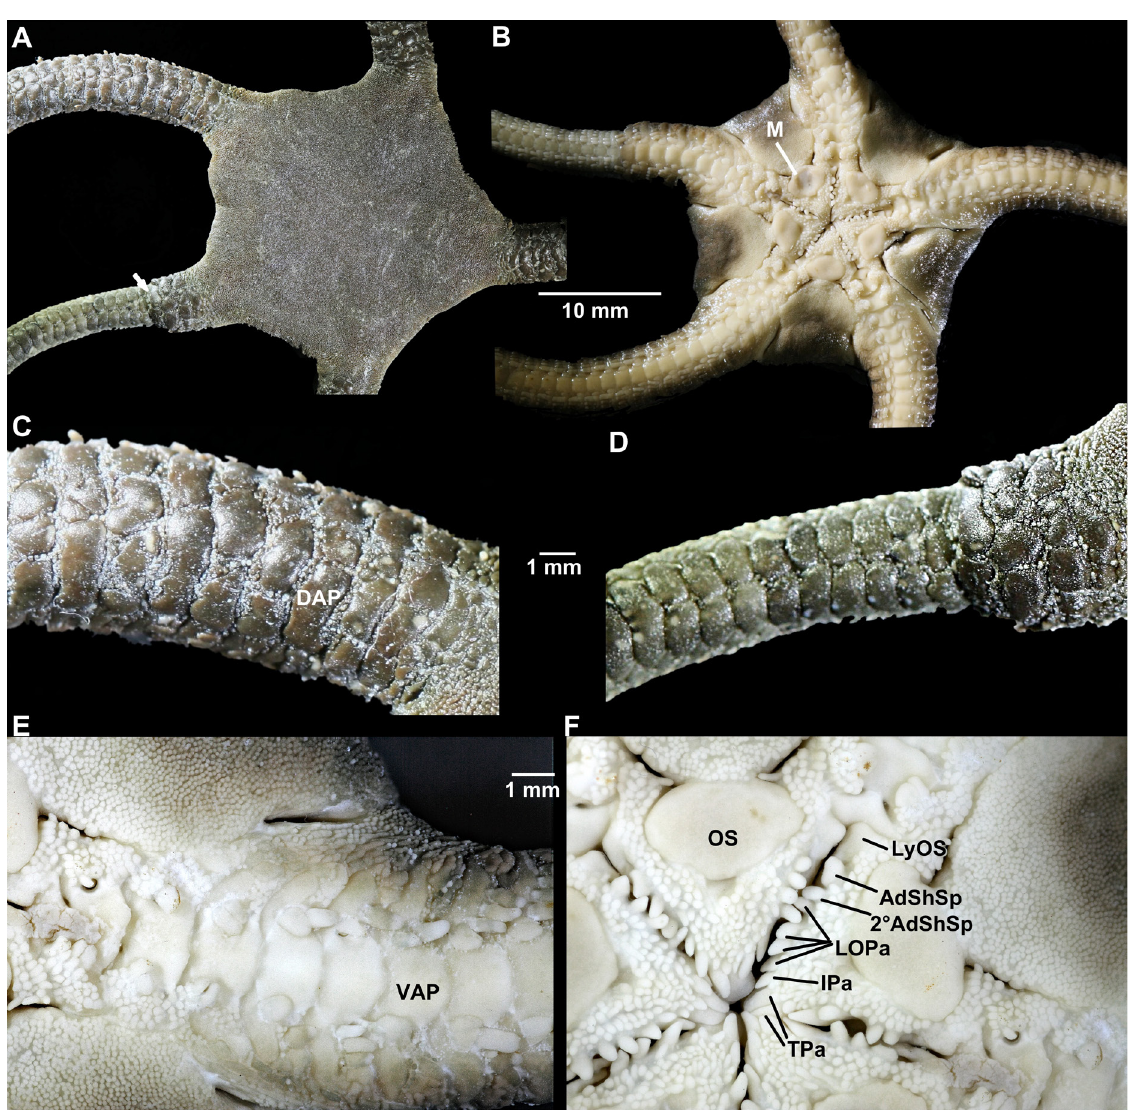
Fig. 2. Ophioderma longicauda (Bruzelius, 1805), neotype (SMNH-Type-8729), digital images. A . Dorsal disc and arm bases, arrow points to regenerating part. B . Ventral disc and basal arms. C . Basal dorsal arm, note the multiple dorsal plates. D . Regenerating arm, dorsal plates already more than one. E . Ventral arm base. F . Jaws. Abbreviations: 2°AdShSp = second adoral shield spine; AdShSp = adoral shield spine; DAP = dorsal arm plate; IPa = infradental papilla; LOPa = oral papillae; LyOS = Lyman’s ossicle; M = madreporite; OS = oral shield; TPa = tooth papillae; VAP = ventral arm